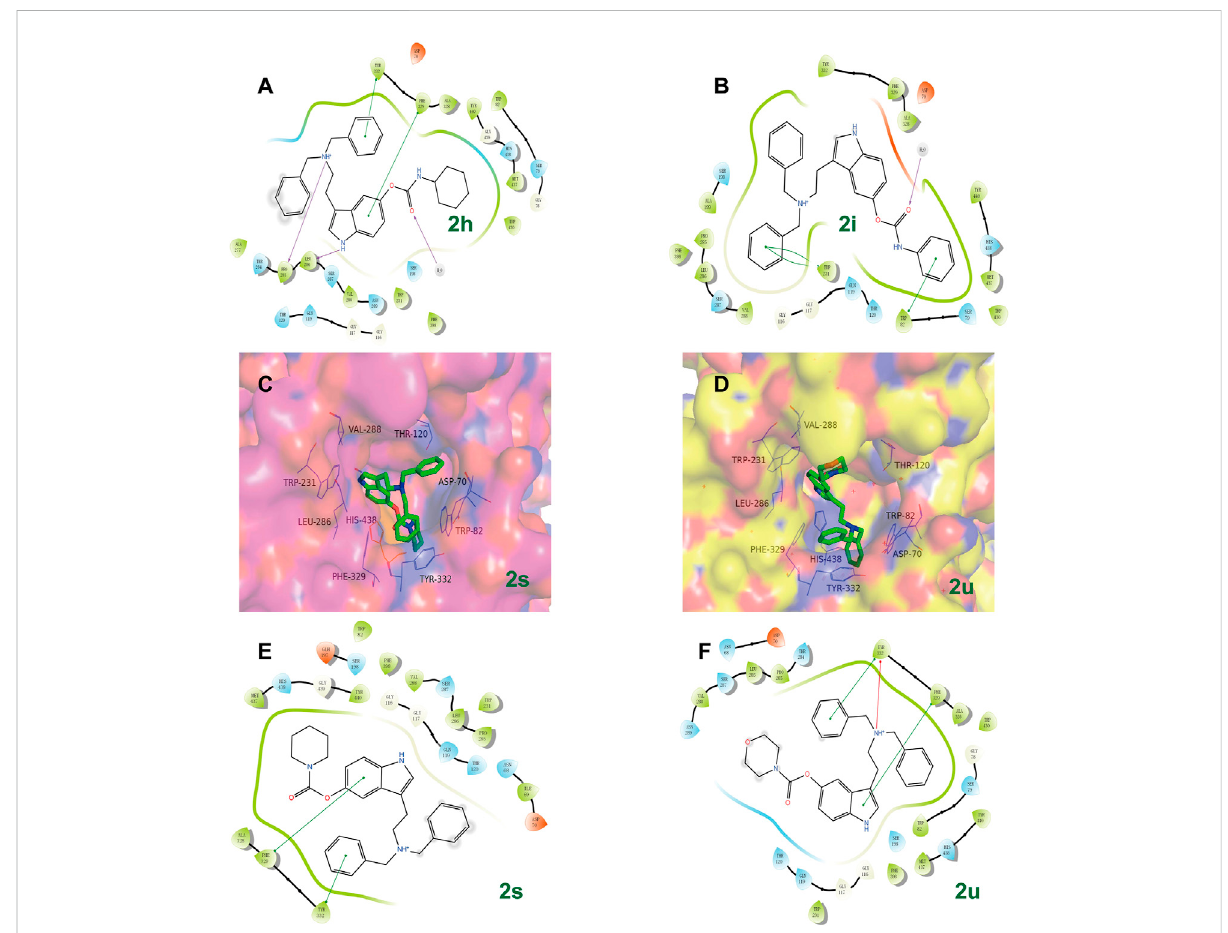
FIGURE 2 The possible binding mode for the compounds 2h , 2i , 2s , 2u in the BuChE (PDB code:4TPK) binding sites. (A,B,E,F) The 2D images of 2h , 2i , 2s , 2u , respectively, binding to BuChE predicted by Schrodinger software (Release 2019-2, Schrodinger, LLC, New York, NY, 2019). The purple arrow indicates hydrogen bond, the red arrow indicates π – cation interaction, and the green line indicates π – π interaction. (C,D) The potential distribution surface diagrams of 2s and 2u , respectively, created by Pymol